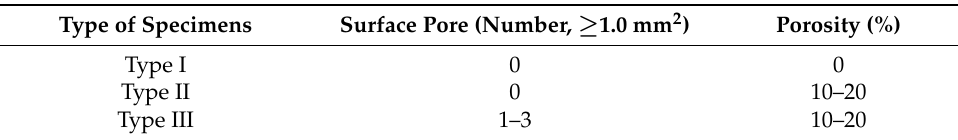
Table 4. Classification conditions of the fatigue test specimens.